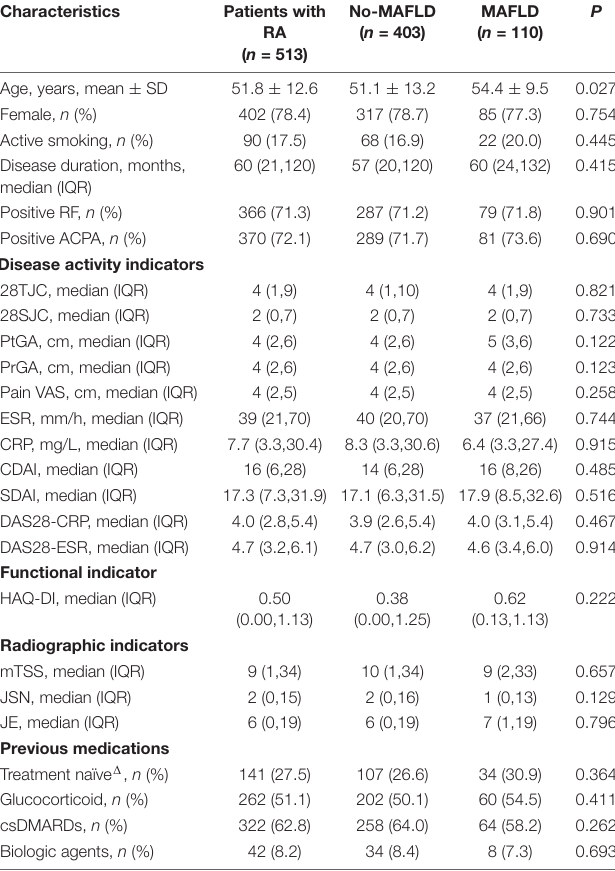
TABLE 1 | Demographic and clinical characteristics of RA patients with